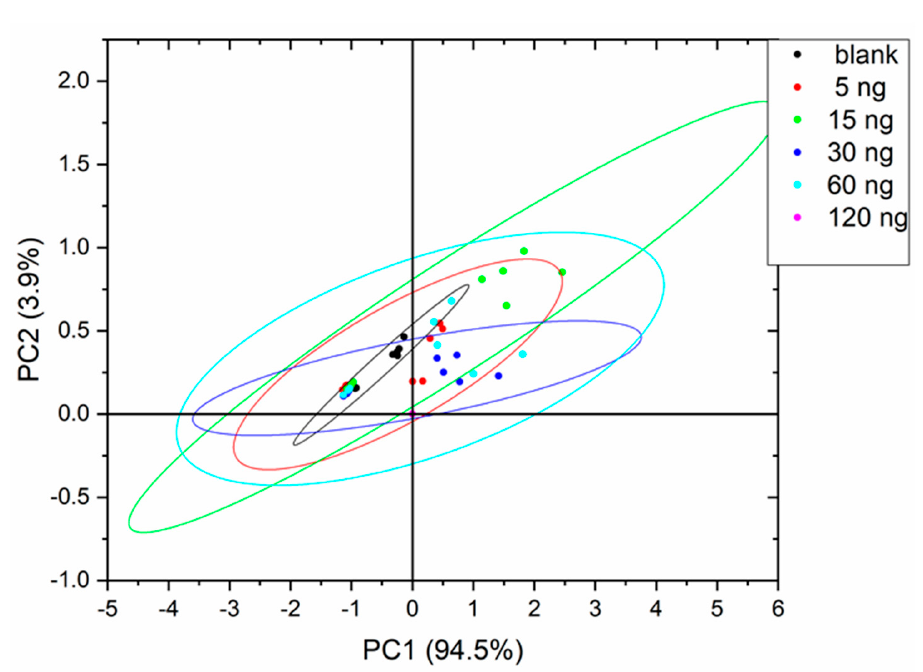
Figure 5. PCA score plot for 1-octen-3-one.